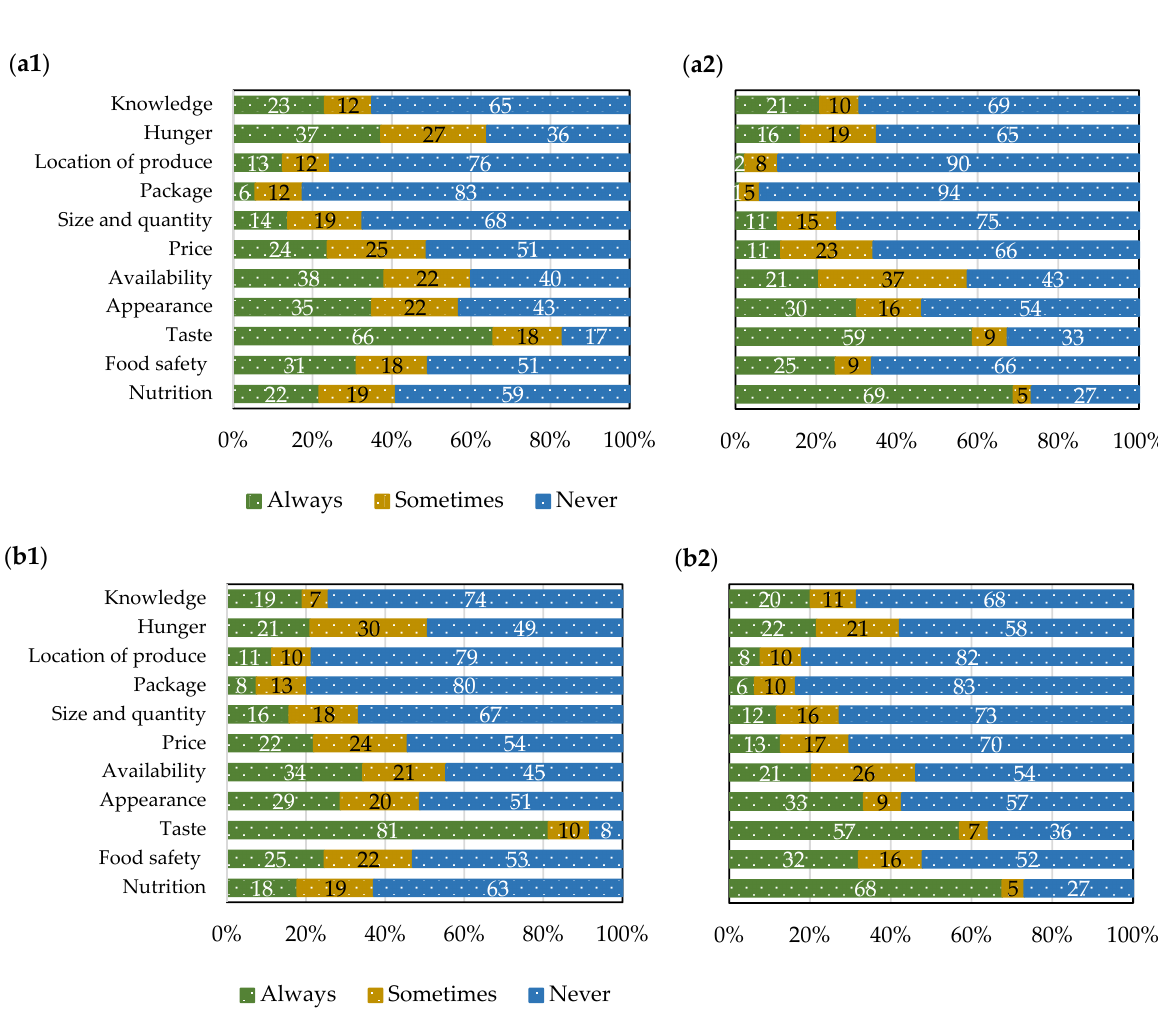
Figure 3. Factors influencing consumer choice for consuming fresh plantain ( a ) and their products 1 ( b ) in Cameroon ( 1 ) and Nigeria ( 2 ). 1 An average value of all plantain-based products including boiled, roast, chips, dodo, flour, pounded, and porridge; however, flour was excluded from plantain-based products in Cameroon due to unavailability.